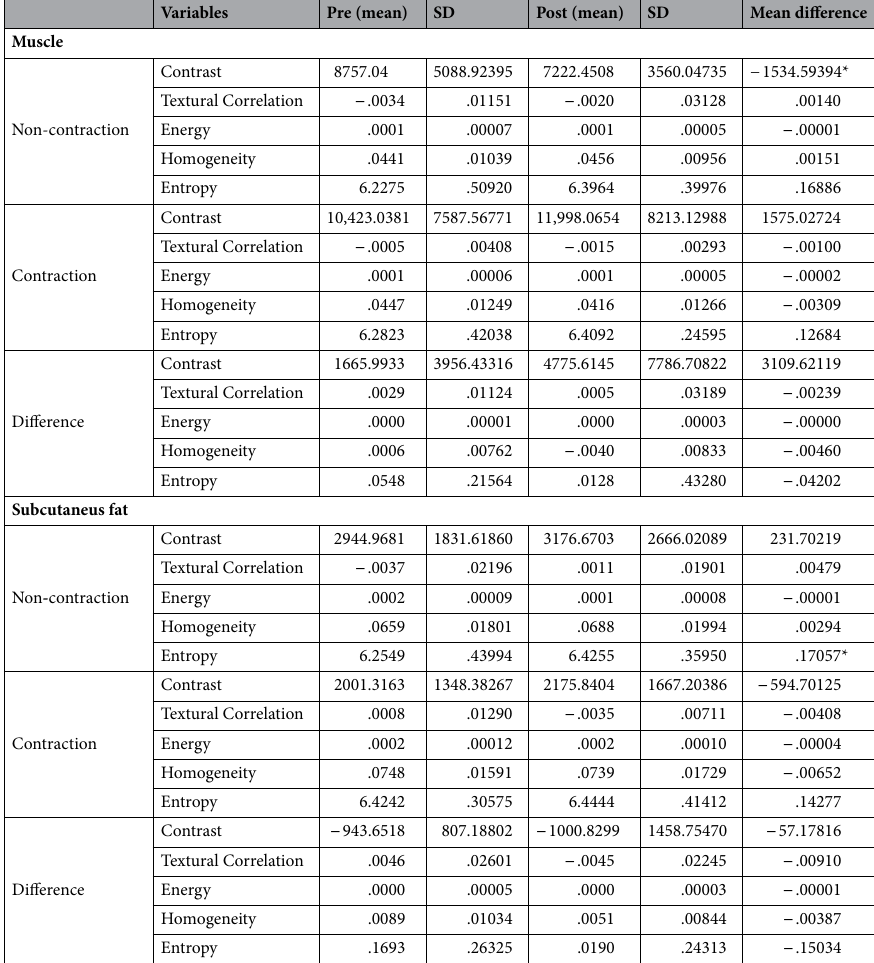
Table 2. Textural analysis in quadriceps during the pre and post intervention (n = 13). * P <